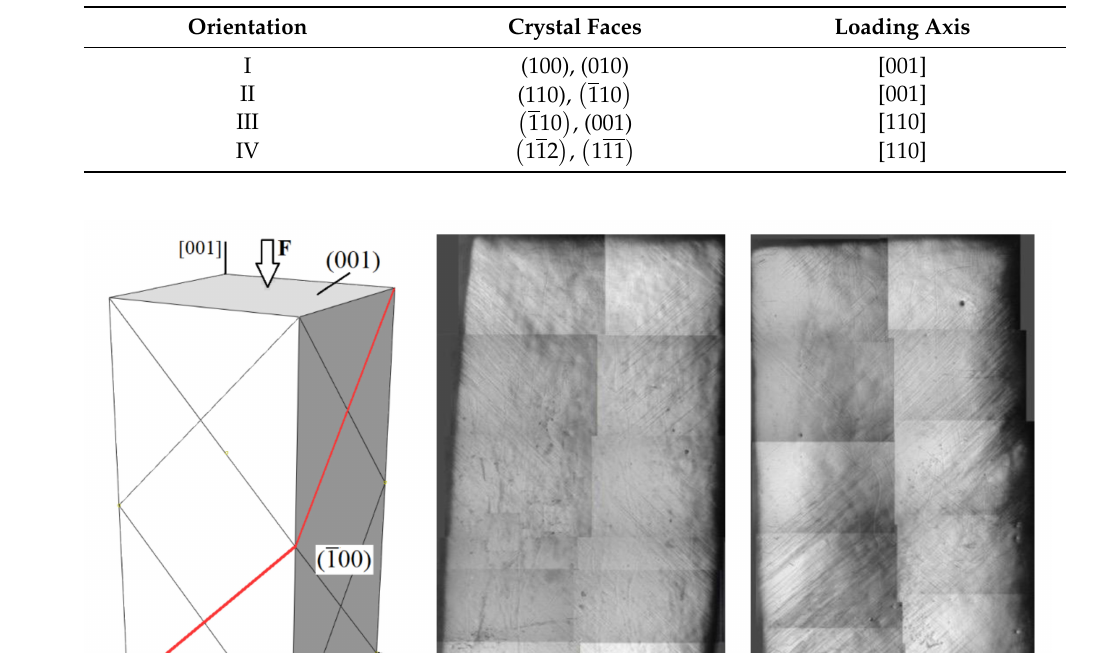
Table 1. Single-crystal geometry.